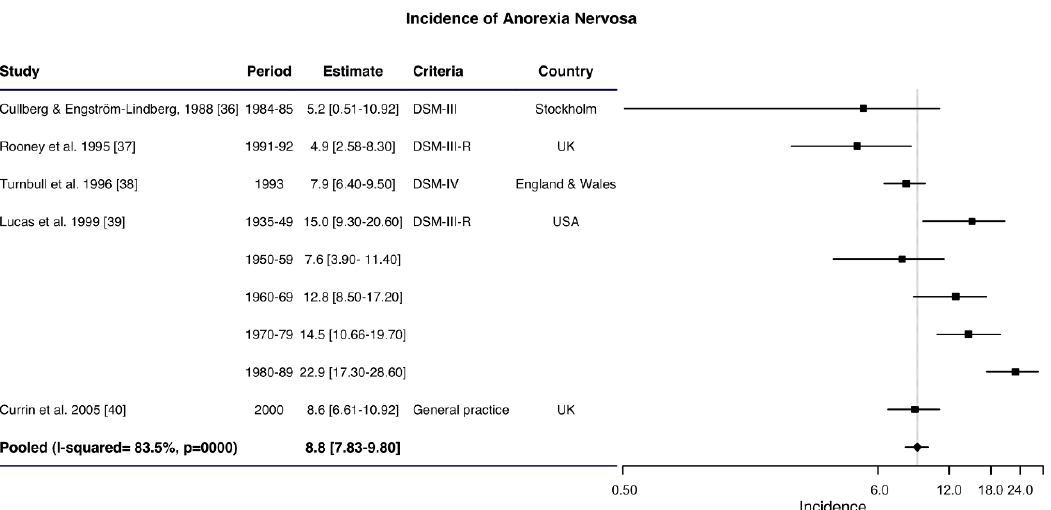
Figure 4. Forest plot of the meta-analysis of anorexia nervosa incidence rates in women in outpatient healthcare services.